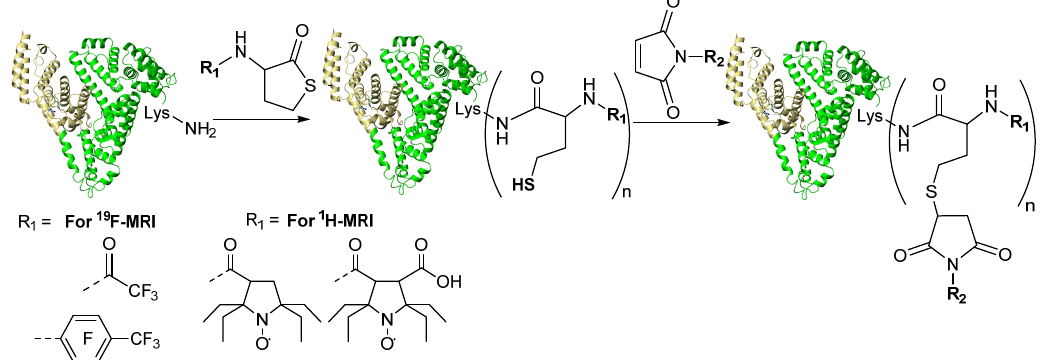
Figure 7. Two-step protocol for the functional polymer solid-state synthesis using HTL derivative building block approach.